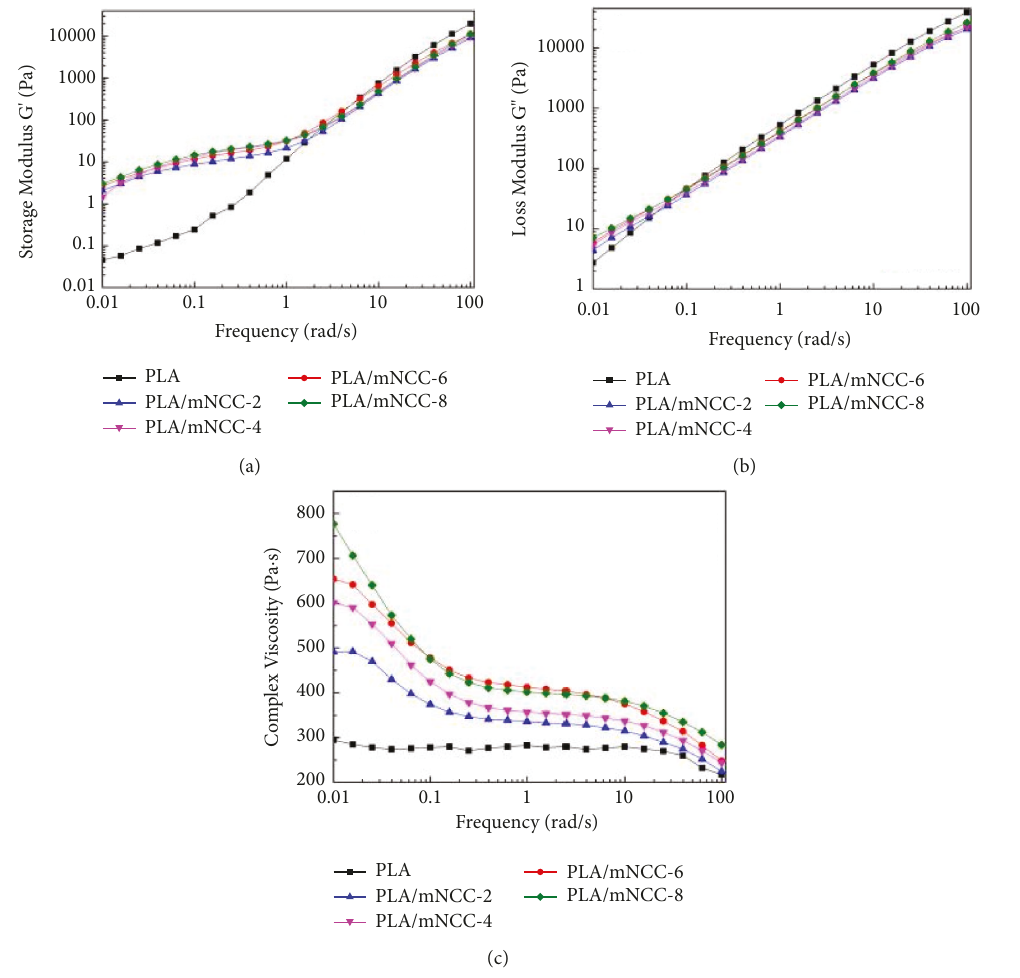
Figure 5: Dynamic rheological behaviors of the PLA nanocomposites (test temperature 170 ° C): (a) storage modulus G ′ , (b) loss modulus G ″ , and (c) complex viscosity η ∗